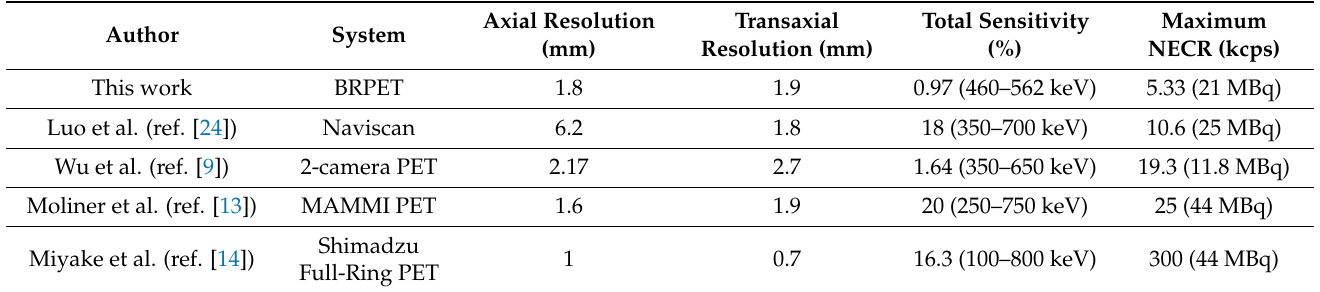
Table 6. Comparison of key imaging performance metrics of BRPETamong compared to those of several commercial dbPET